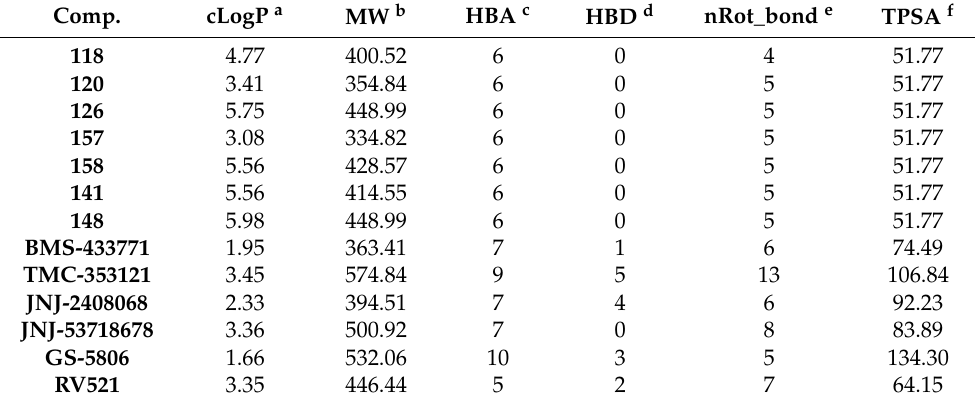
Table 3. Calculated parameters related to the Lipinski’s rules and to the Veber’s rules, referred to the N(1)-benzotriazolyl-containing benzimidazoles 118 , 120 , 126 , 157 , and 158 (in green), the N(2)- benzotriazolyl-based 141 , 148 (in yellow), the (pre)clinical (in gray) and clinical (in cyan) candidates TMC353121, BMS-433771, JNJ-2408068, and JNJ-53718678, GS-5806, RV521, respectively.